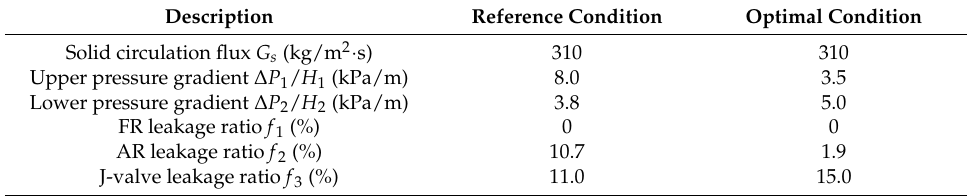
Table 3. Comparison of gas leakages between the reference condition and optimal